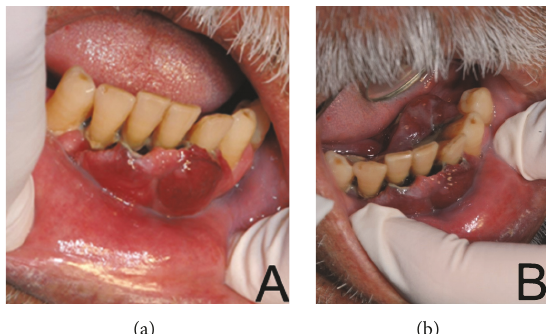
Figure 1: Nodular lobed and sessile lesion, with flabby consistency and dark red color covering the mandibular teeth, affected by periodontal disease (a), and extending to the floor of the mouth (b).